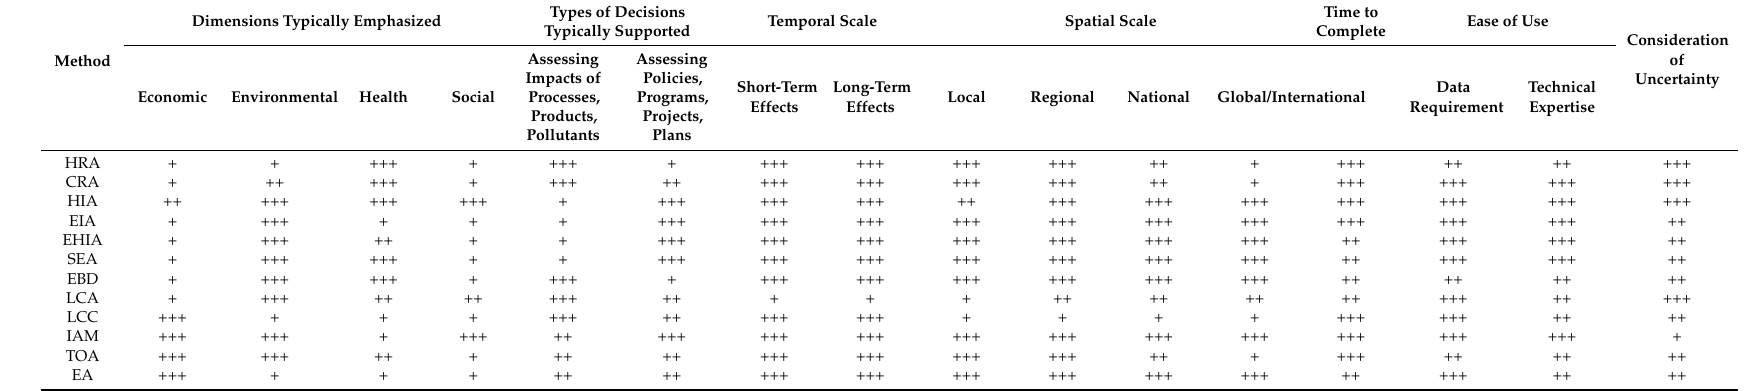
Table 3. The comparison of environmental health assessment method attributes